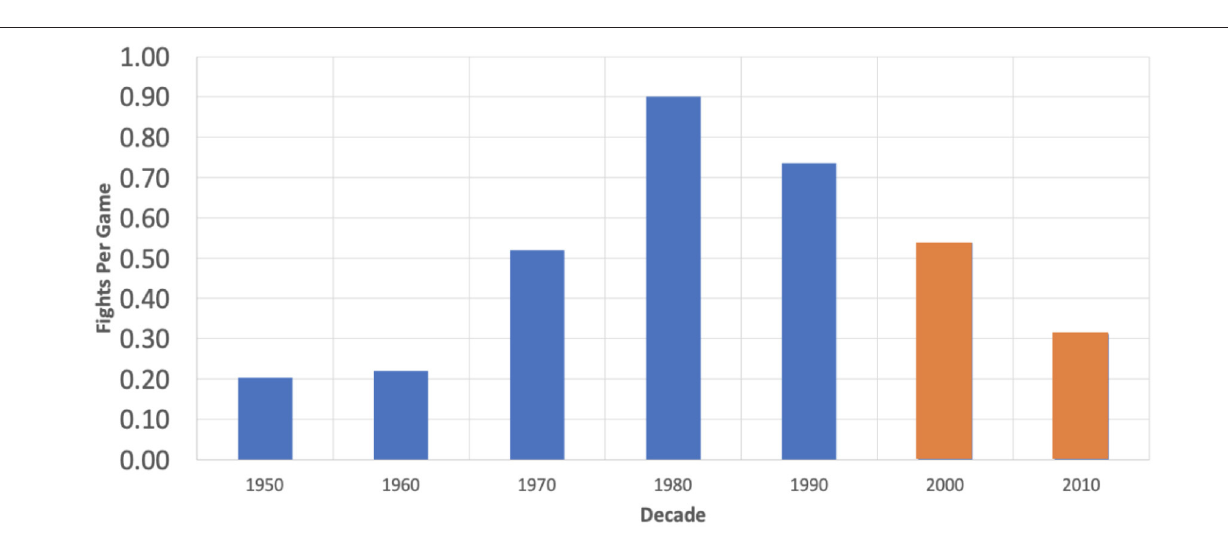
FIGURE 2 | Graph and table reporting the average fights per game by decade in the